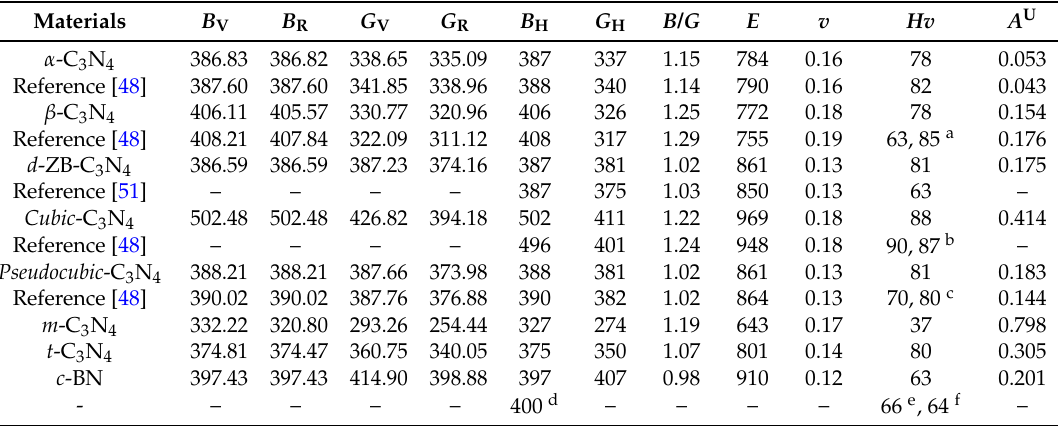
Table 3. The calculated elastic modulus (GPa), B / G , hardness Hv (GPa) and the universal